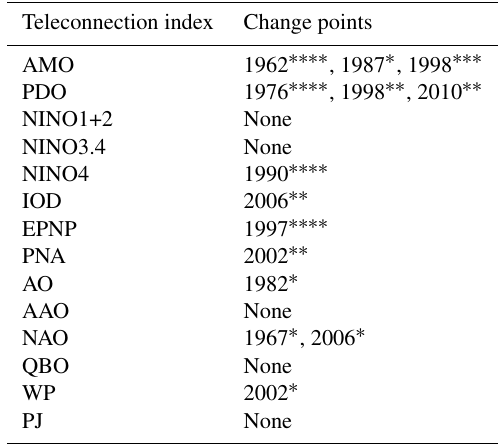
Table 5. Change points (shifts in the mean) identified for all the JAS teleconnection indices examined in this